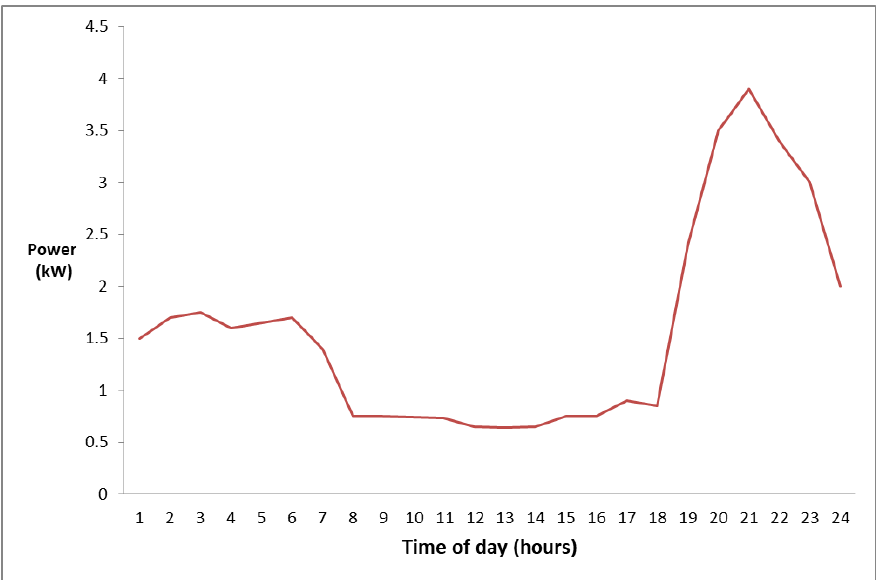
Figure 11. Measured load profile from [25].